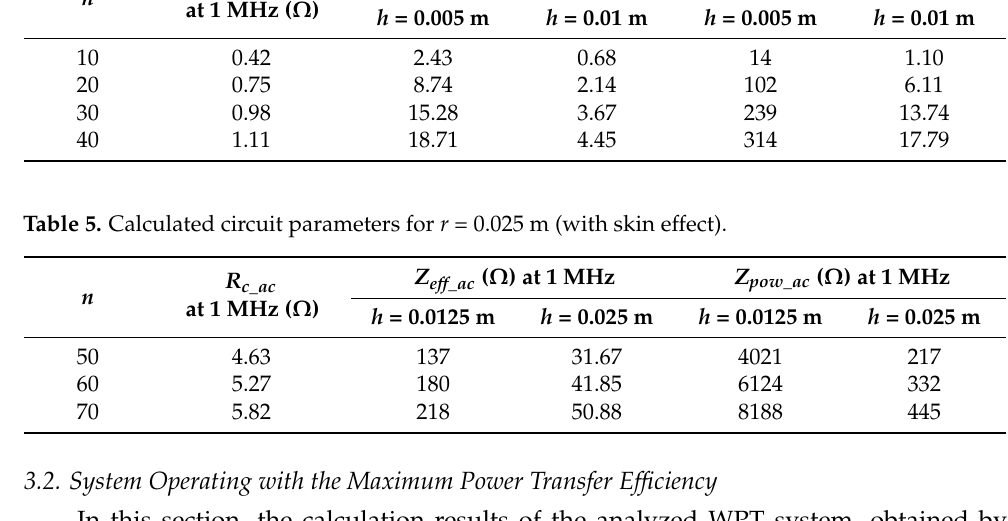
( b ) Figure 6. Load impedance for the cases with and without skin effect at 1 MHz for the large coil at ( a ) h = 0.0125 m; ( b ) h = 0.025 m. In Figure 7, the resistances of coils are presented ( r = 0.01 m and r = 0.025 m). Skin effect increases coil resistance by approx. 30% for small and large coils and regardless of the number of turns. ( a ) ( b ) Figure 7. Coil resistance with skin effect at 1 MHz and without skin effect for ( a ) small coil; ( b ) large coil.